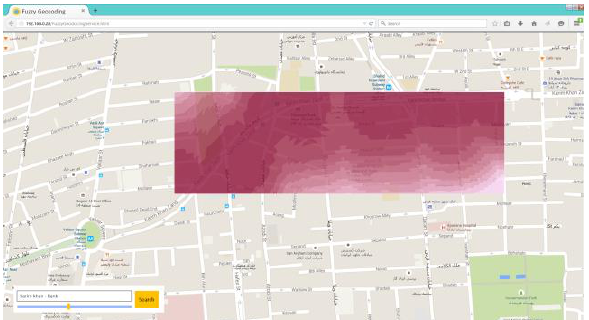
Figure 6. Output of Scenario 1